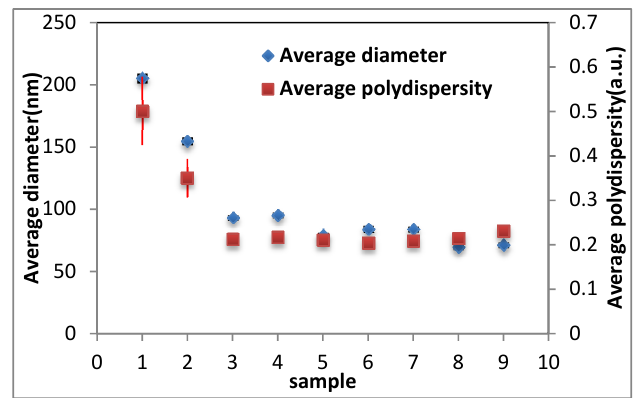
Figure 3. Average diameter and polydispersity of keratin extract constituents from different filtration steps determined by DLS from three repeats. Samples 0–3: D0–D3 (D = dialyzed and the number corresponds to days); samples 4–9: DF1, DF3, DF5, DF8, DF10, DF14 (DF = dialyzed and diafiltered and the number corresponds to cycles). The data for sample D0 (keratin extract before dialysis) was out of range and not shown.